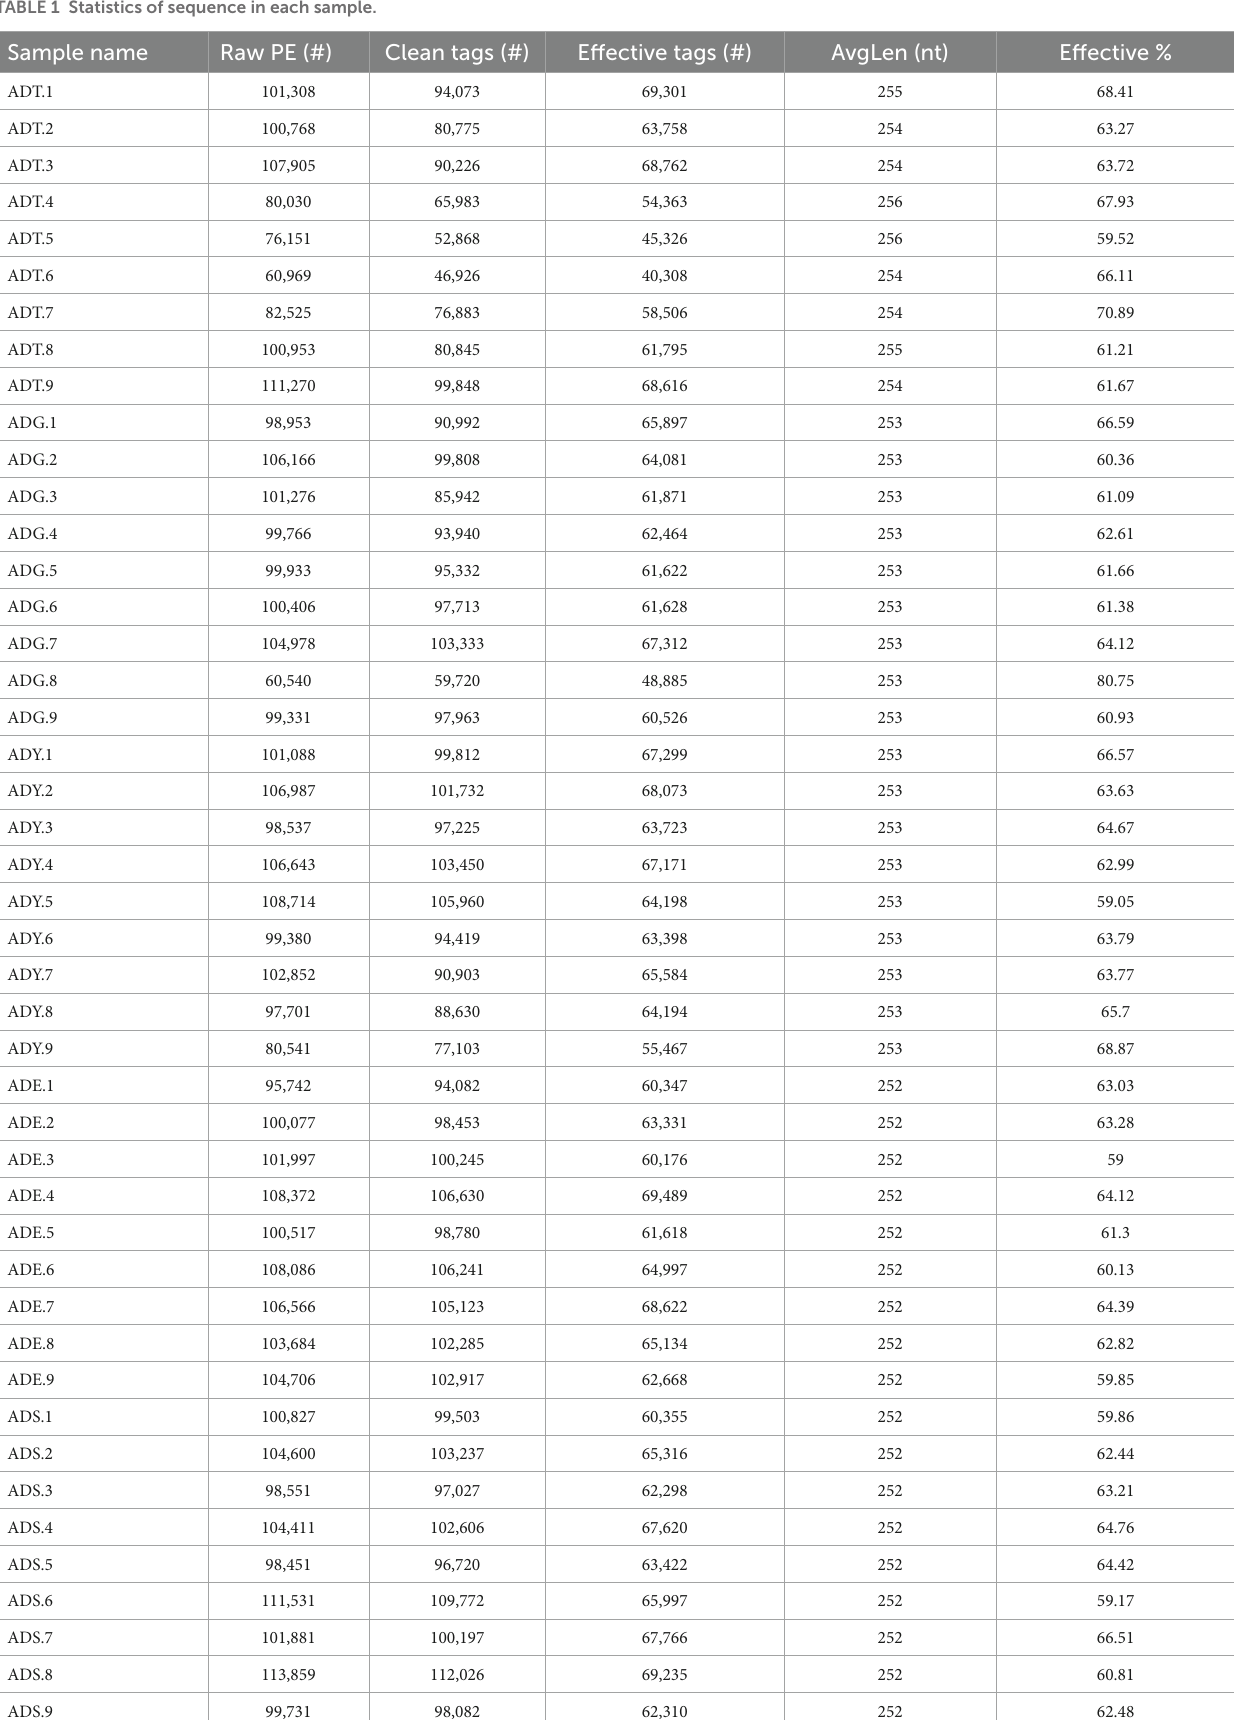
TABLE 1 Statistics of sequence in each